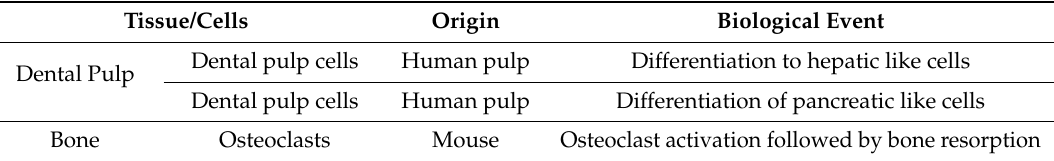
Table 3. Biological effects of low physiological concentrations of H 2 S on different oral cell types (1 ng/mL H 2